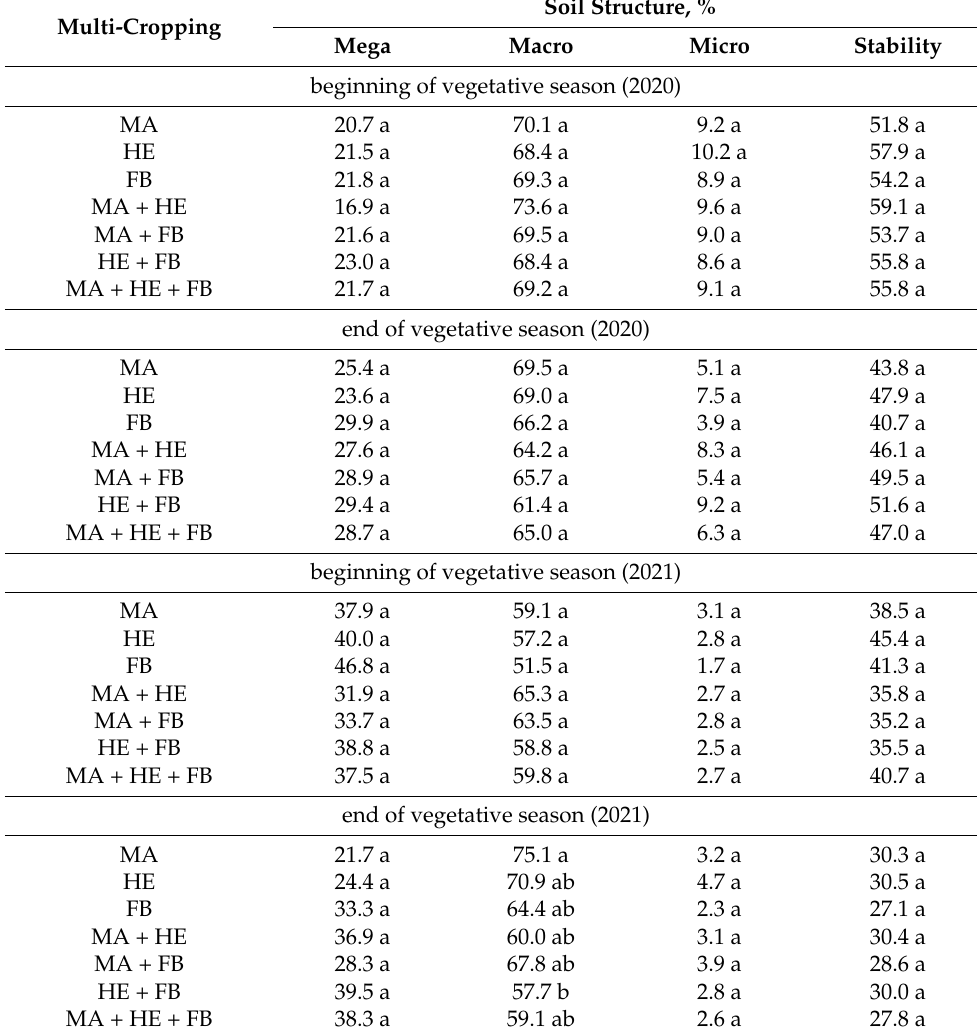
Table 3. Impact of multi-cropping on soil structural composition and stability, 2020–2021.